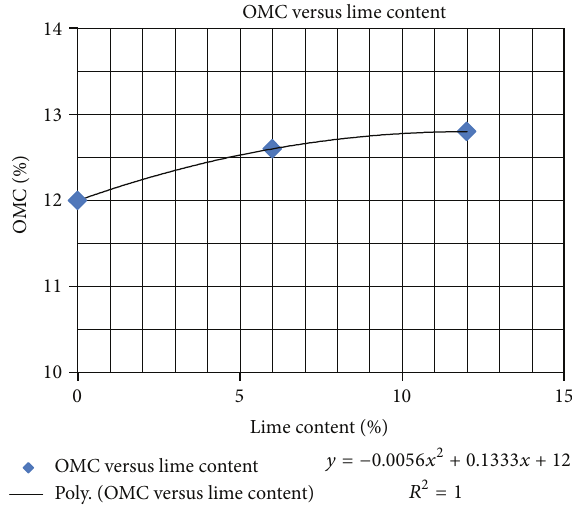
Figure 7: Compaction curve of unstabilized and stabilized WDA specimens at different contents of lime.